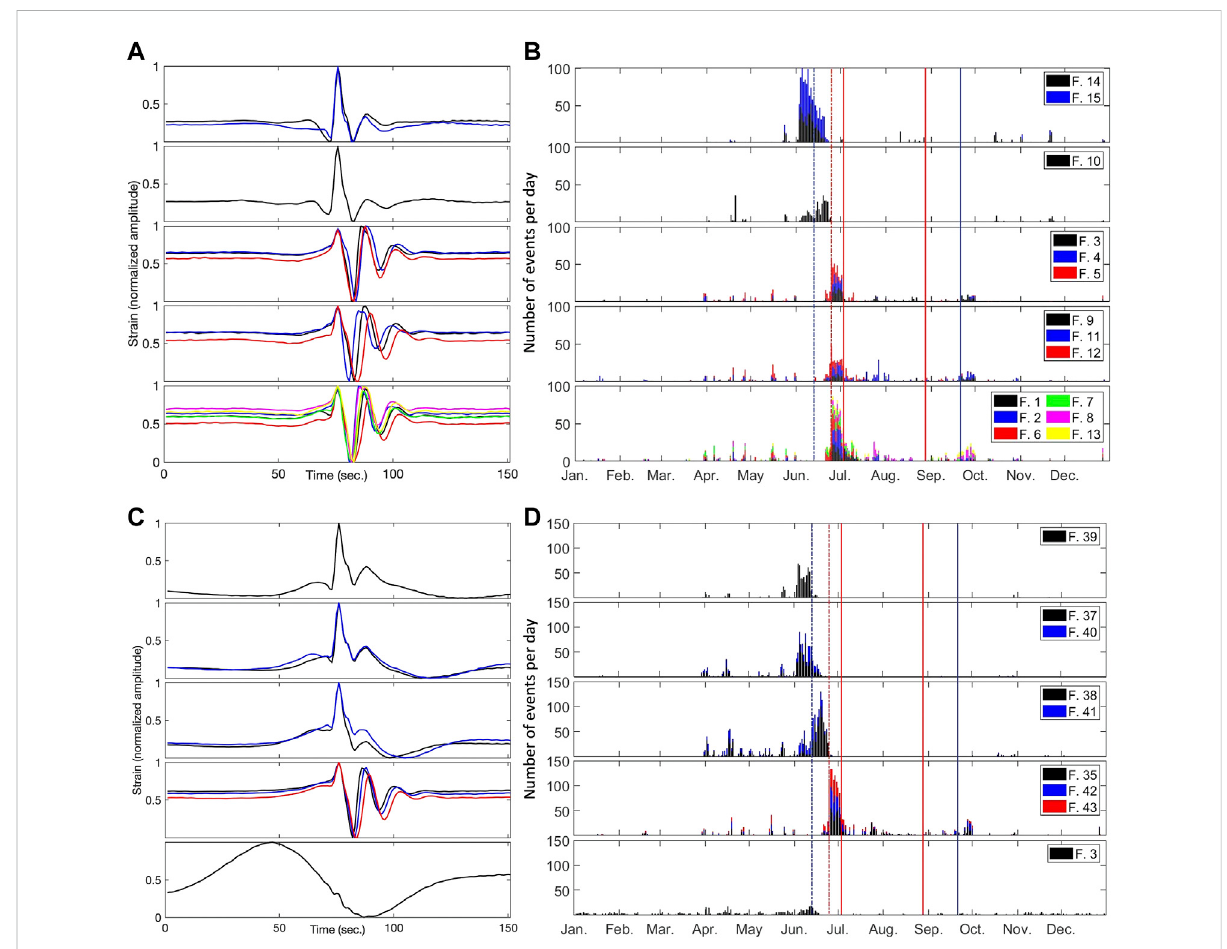
FIGURE 9 CCclusteroffamiliescorrelatedwithdifferentvolcanicactivity (A,C) VLPandULPNormalizedstackedwaveformsrespectively (B,D) Histograms of VLP- and ULP- data. Both spectral intervals locate families whose cumulative number of events per day tend to change as July 3 paroxysm approaches. For ULP events, a “ bad weather condition ” family (Family 3 in the last panel) is plotted to show its different shape in respect to volcanic activity families. The blue dashed line marks the VT occurrence on June, 13; the red dashed line marks a major explosion; the two red vertical solid lines mark the two paroxysmal events; the blue solid line marks the lowering of the explosive activity